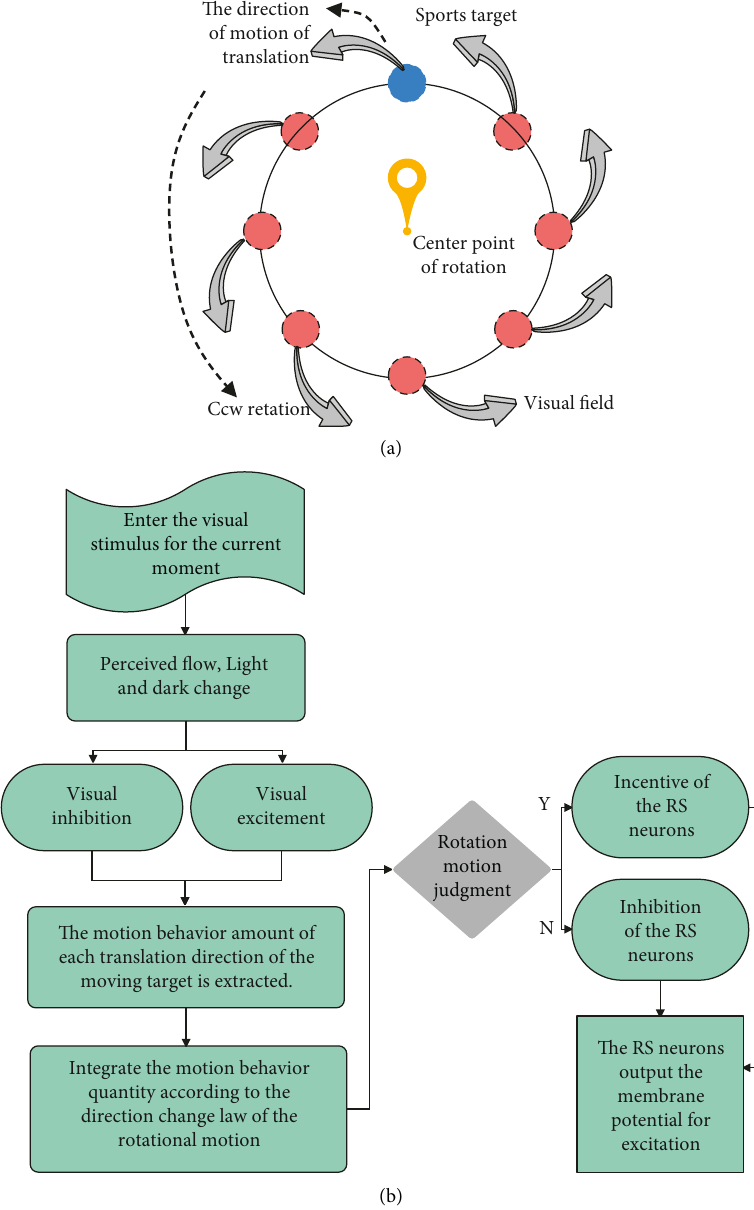
Figure 6: (a) Schematic diagram of the movement direction change of the moving target in the frontal-parallel plane rotating motion; (b) the basic visual mechanism of RS neuron detecting the rotational movement